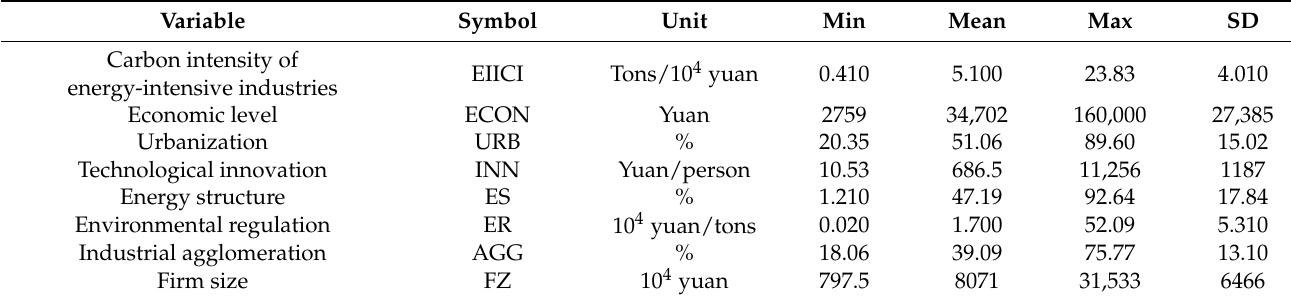
Table 1. Description of the